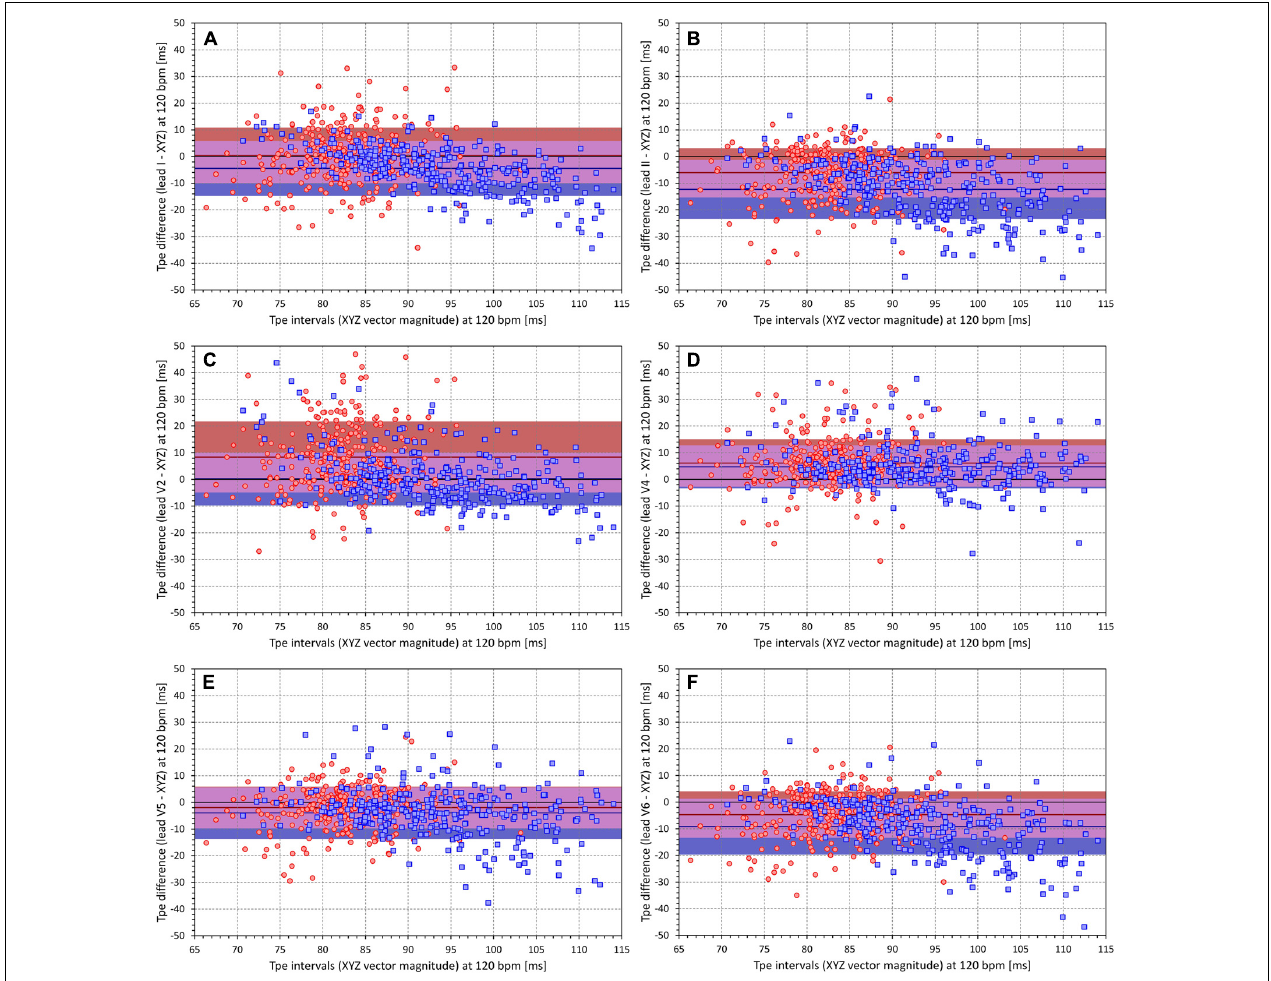
FIGURE 10 | All panels have the same meaning as the panels of Figure 9 , but instead of Tpe values individually projected to the heart rate of 60 bpm, values projected to the heart rate of 120 bpm are displayed. Please see the legend of Figure 9 and the labels of the axes for the explanation of panels (A–F)